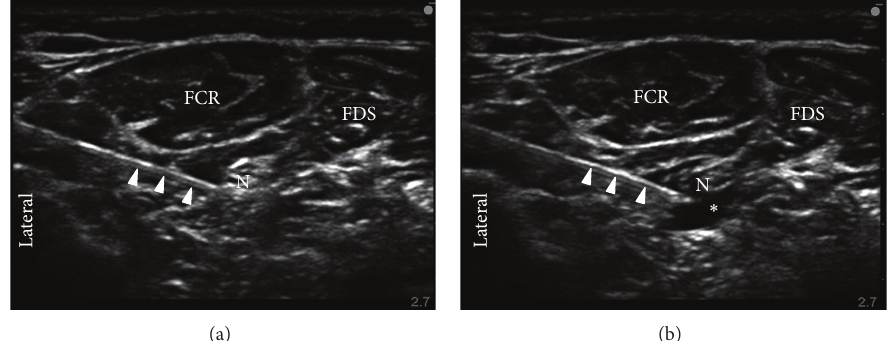
Figure 1: Short-axis sonograms of ultrasound-guided median nerve block at two time points: preinjection (a) and postinjection (b); arrows identify the needle; N = nerve; FCR = flexor carpi radialis muscle; FDS = flexor digitorum superficialis muscle; ∗ = injectate solution.